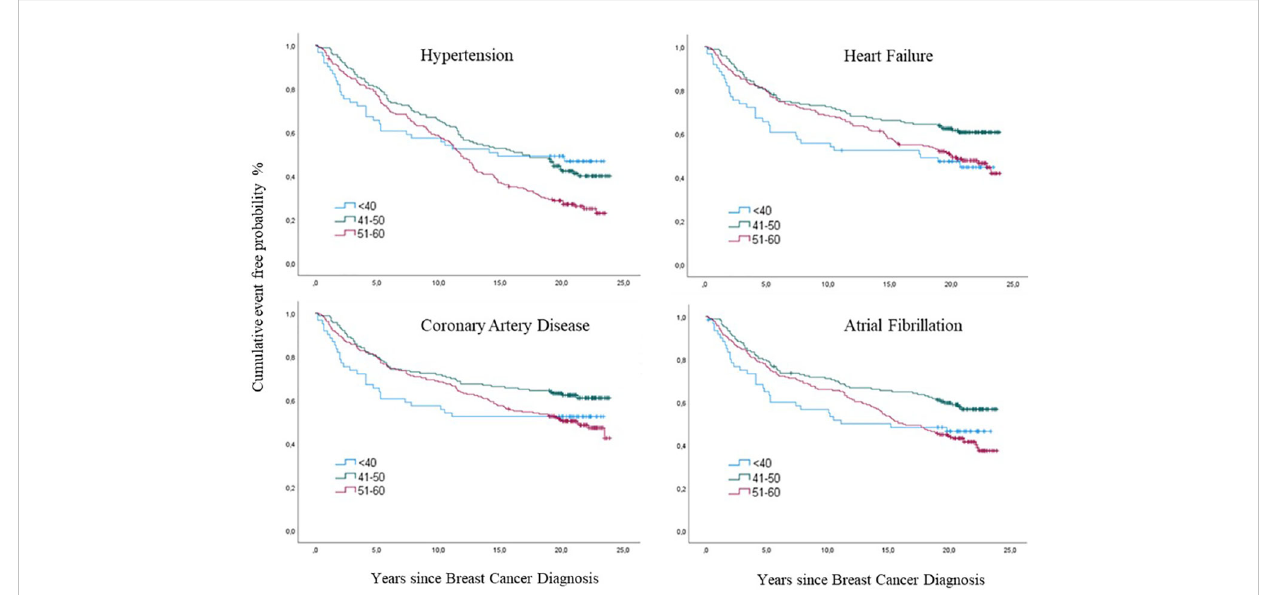
FIGURE 7 Cumulative incidences of cancer therapy-related cardiovascular toxicity (CTR-CVT); hypertension (HT), coronary artery disease (CAD), heart failure (HF) and atrial fi brillation (AF) by age group at diagnosis of breast cancer (BC) by years since diagnosis, with death as a competing Risk, in 433 patients with lymph node-positive early breast cancer at diagnosis in the Southeast Healthcare Region, Sweden, January 1, 1998, to December 31, 2002. The three age groups were ≤ 40-years-of-age, 41-50 years, and 51-60